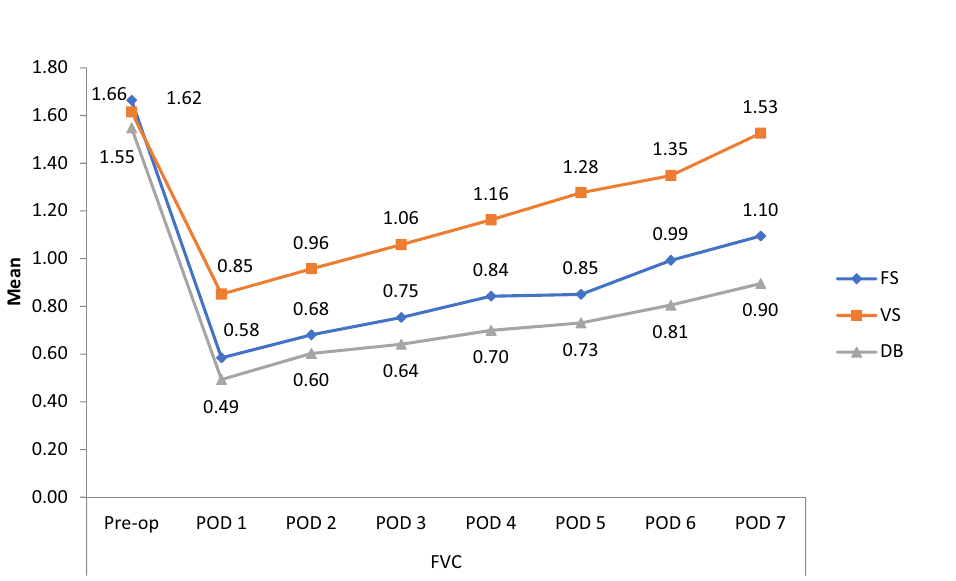
Table 1. Demographic characteristics of subjects undergoing coronary artery bypass graft surgery in all three- intervention groups.